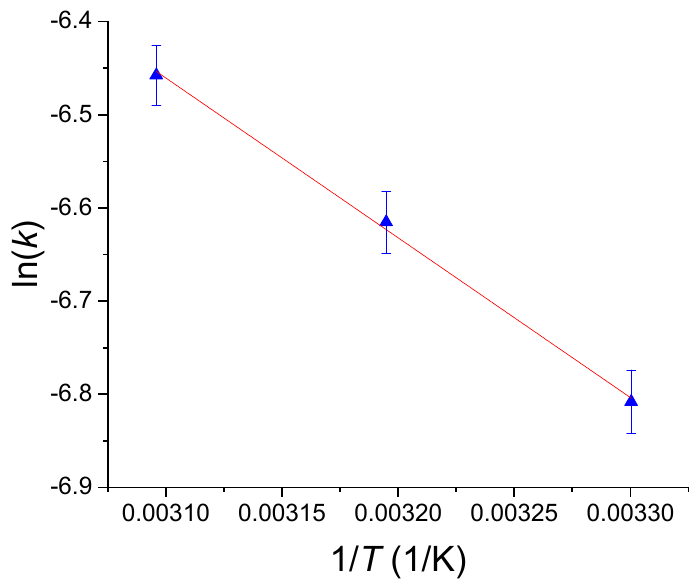
Table 3. Calculated kinetic parameters of the reaction.